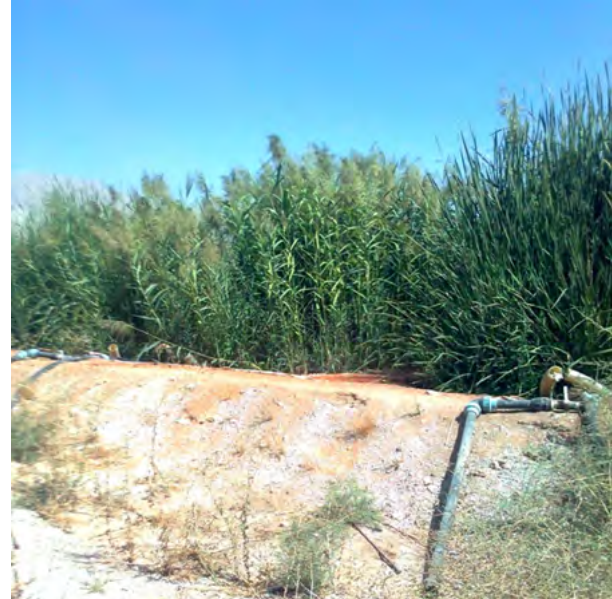
Figure 9. the three species of emerged used plants in the pilot-scale after three months ofplanting.